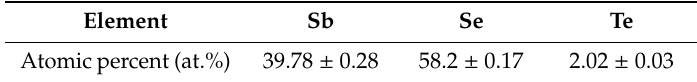
Table 1. The energy dispersive spectroscopy (EDS) results of the Te-Sb 2 Se 3 targets prepared by the melting method in a vacuum (average